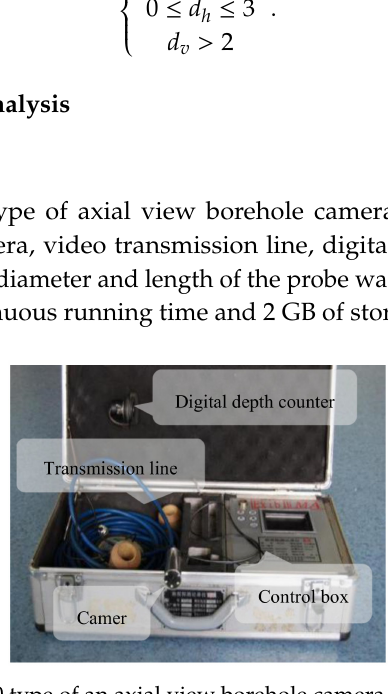
Figure 11. YTJ20 type of an axial view borehole camera system